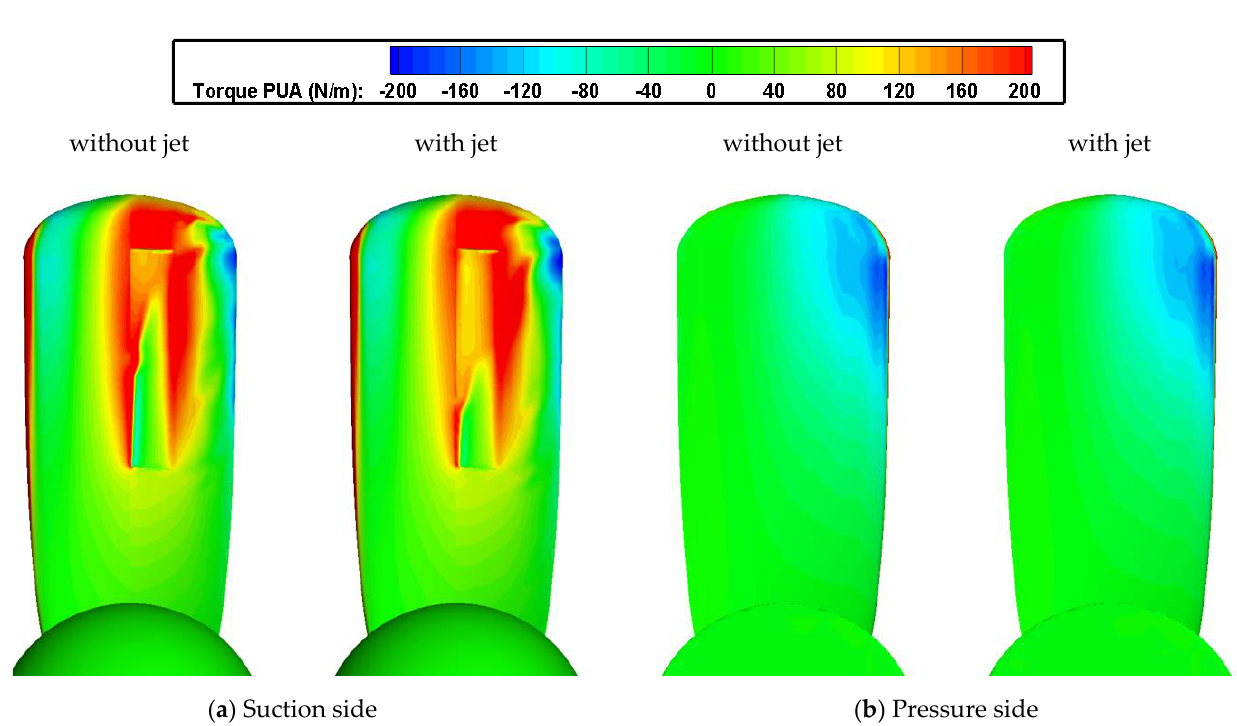
Figure 8. Thrust PUA distribution on the propeller surface with and without jet injection ( J A = 0.4).